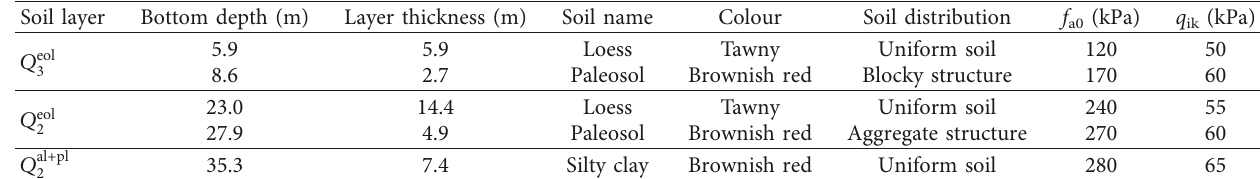
Figure 2: The location of Wuqi–Dingbian Expressway (map data © 2018 Baidu Maps; loess region data © Baidu Encyclopedia; expressway information data © from Shaanxi Provincial Department of Table 2: Properties of the soil in the test area.